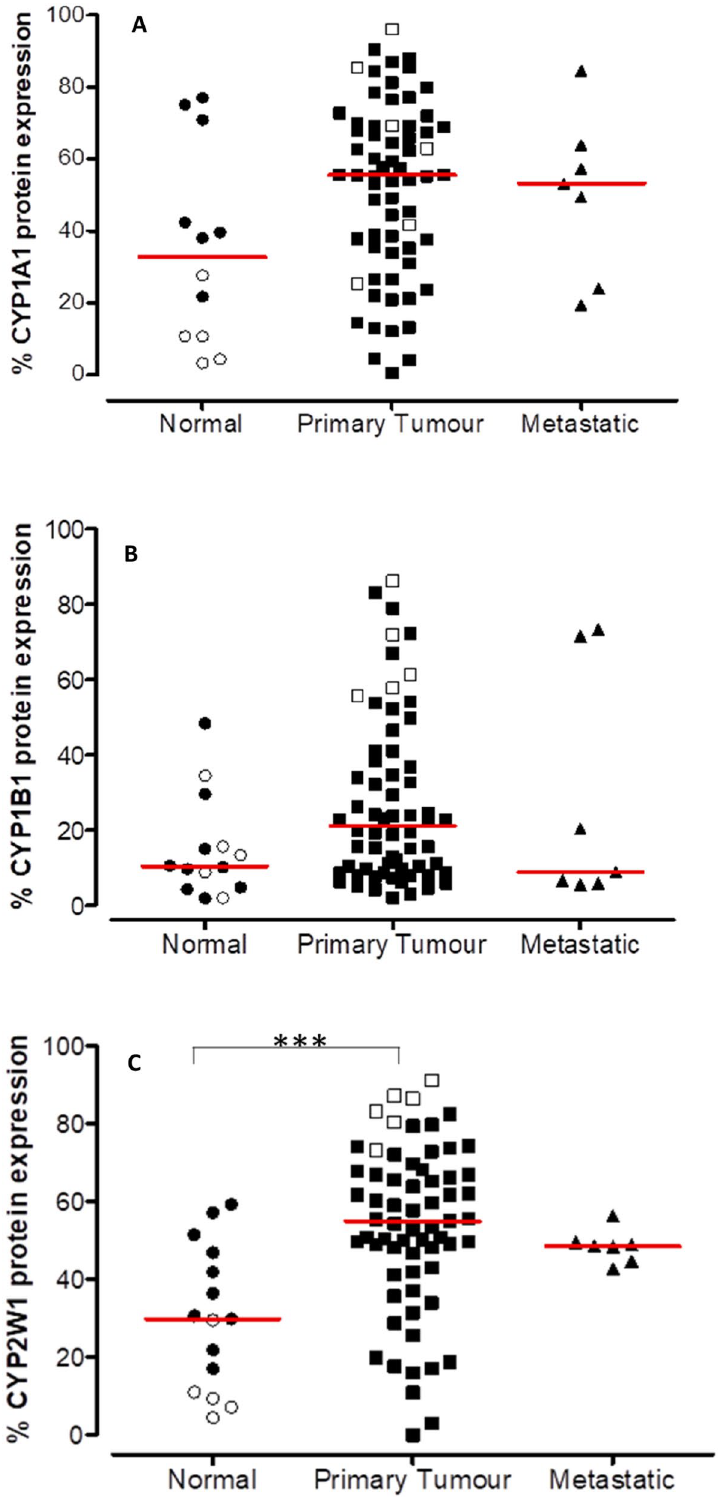
Figure 1. CYP1A1 ( A ), CYP1B1 ( B ) and CYP2W1 ( C ) protein expression in normal, primary tumour and metastatic patient samples. Black symbols represent TMA samples and white are from frozen tissue while the red line represents the median. ***P ≤ 0.001 relatively to normal tissue